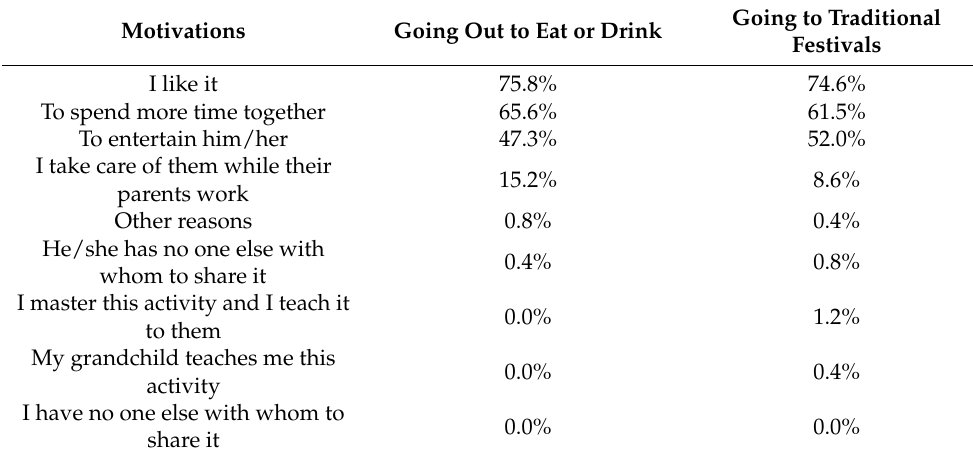
Table 2. Motivations to perform the types of festive leisure